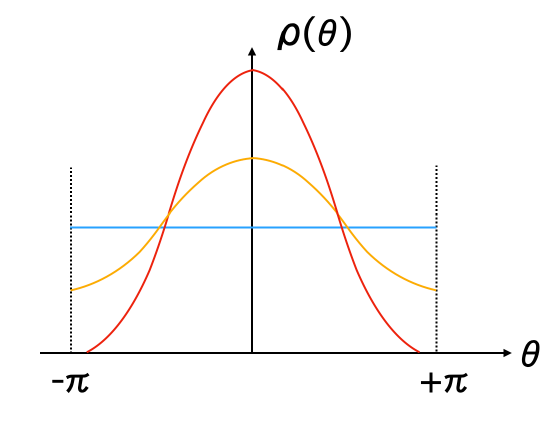
Figure 6. The uniform (blue), non-uniform and non-gapped (orange) and non-uniform and gapped (red) phases. They can be understood as the confined, partially-deconfined and completely- deconfined phases, respectively.